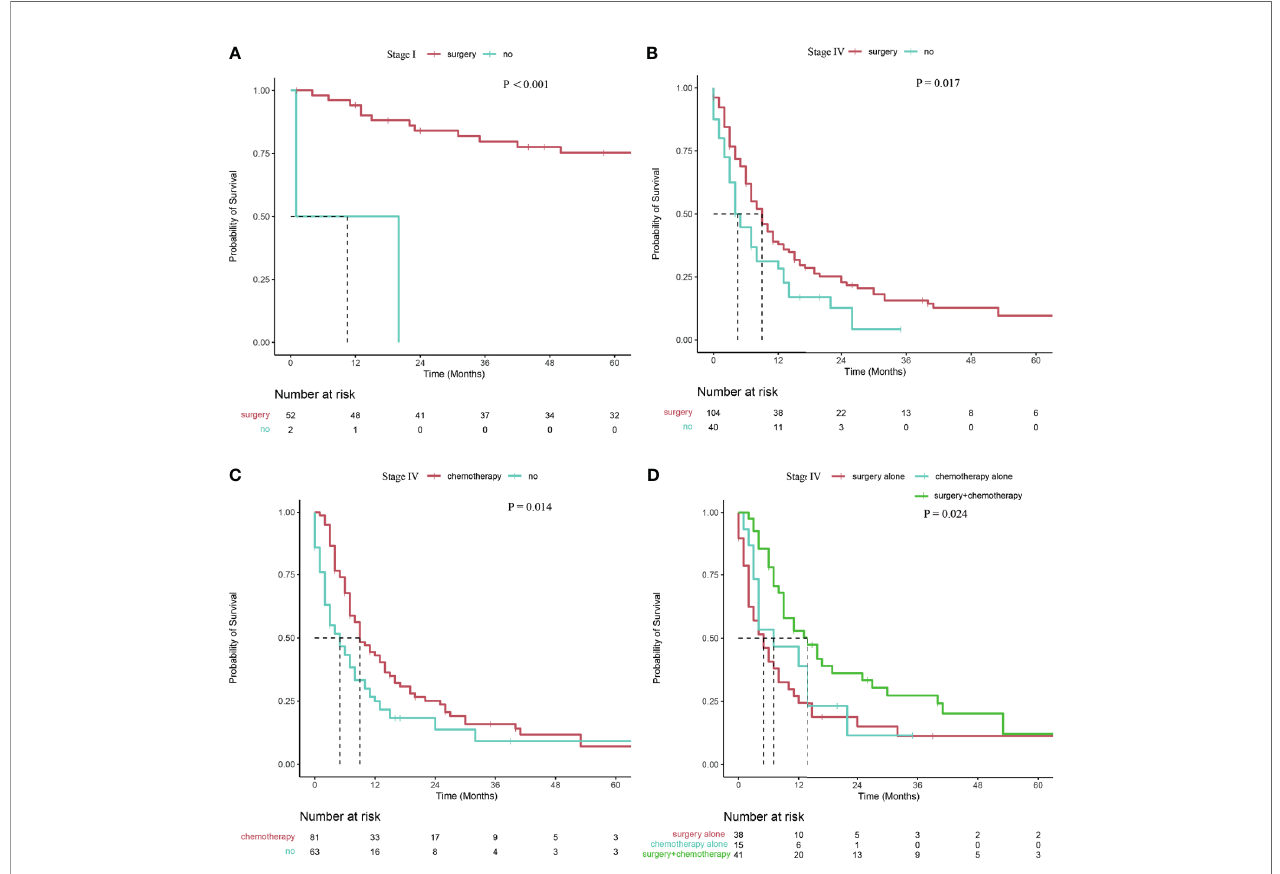
FIGURE 3 | Survival curve of patients with CDCK evaluated using the Kaplan – Meier method (A, B) Surgery strati fi ed according to tumor stage; (C) Chemotherapy strati fi ed according to tumor stage; (D) Surgery and/or chemotherapy alone strati fi ed according to tumor